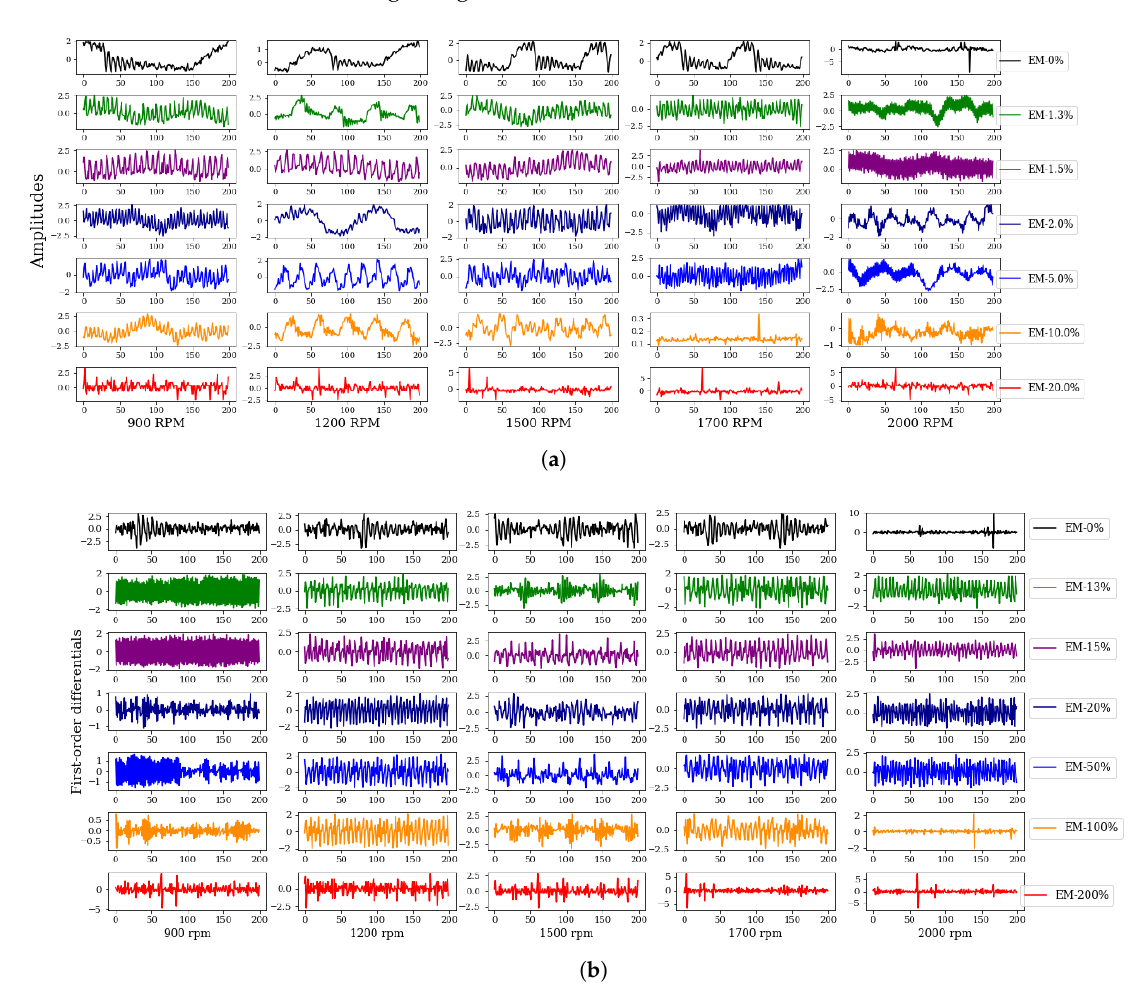
Figure 4. Visualization for ( a ) CR signals for different W/D emulsions (across the rows in unique colors) at the increasing engine speeds (down the columns). ( b ) The normalized first-order differentials of the CR pressure signals at different emulsion